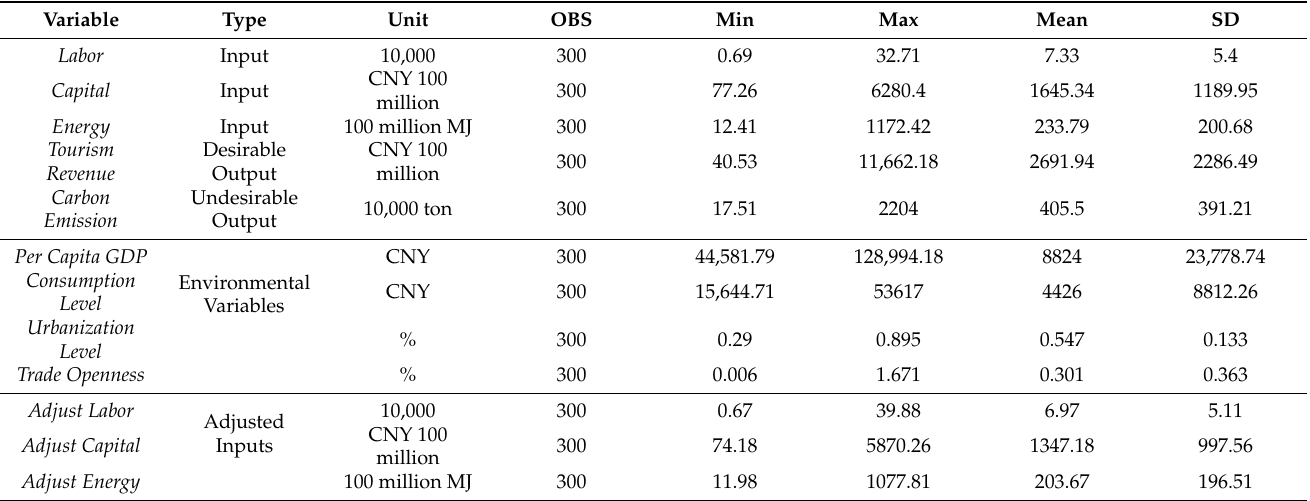
Table 3. Descriptive statistics of main